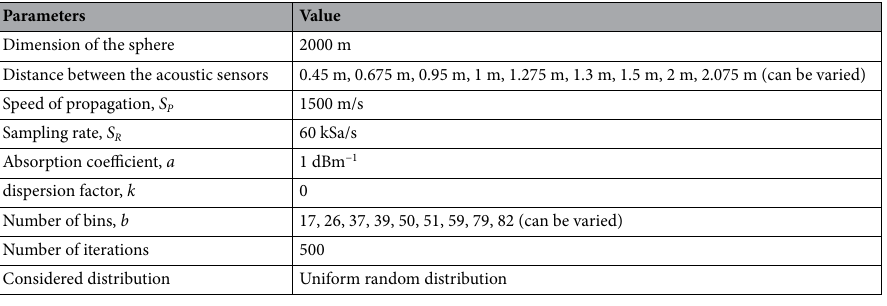
Table 1. Parameters used in the MATLAB